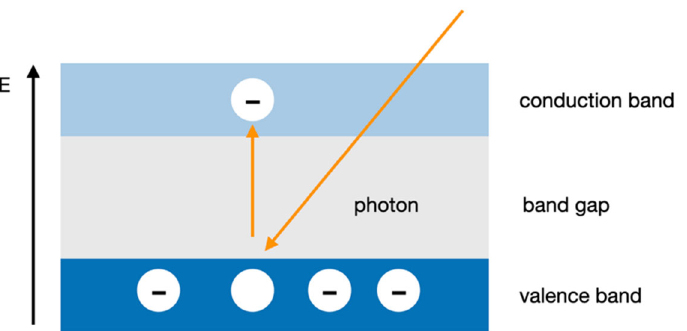
Figure 2. Principle of the formation of electron–hole pairs with ionizing radiation. Bands determine the density of available energy states. E = energy of electrons.